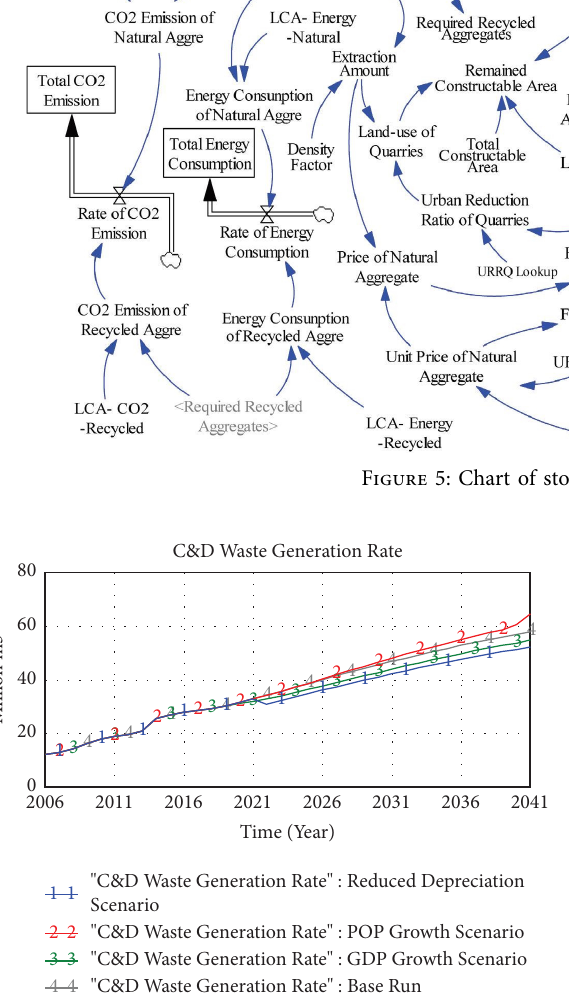
Figure 6: Te variable process of C&D waste generation rate in current state scenarios.